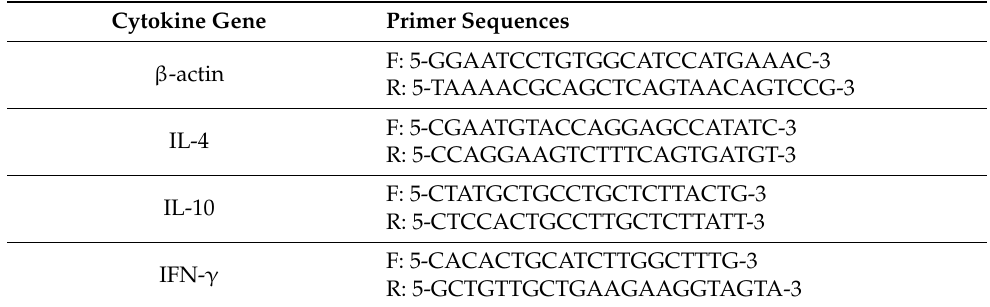
Table 4. Primer sequence used for